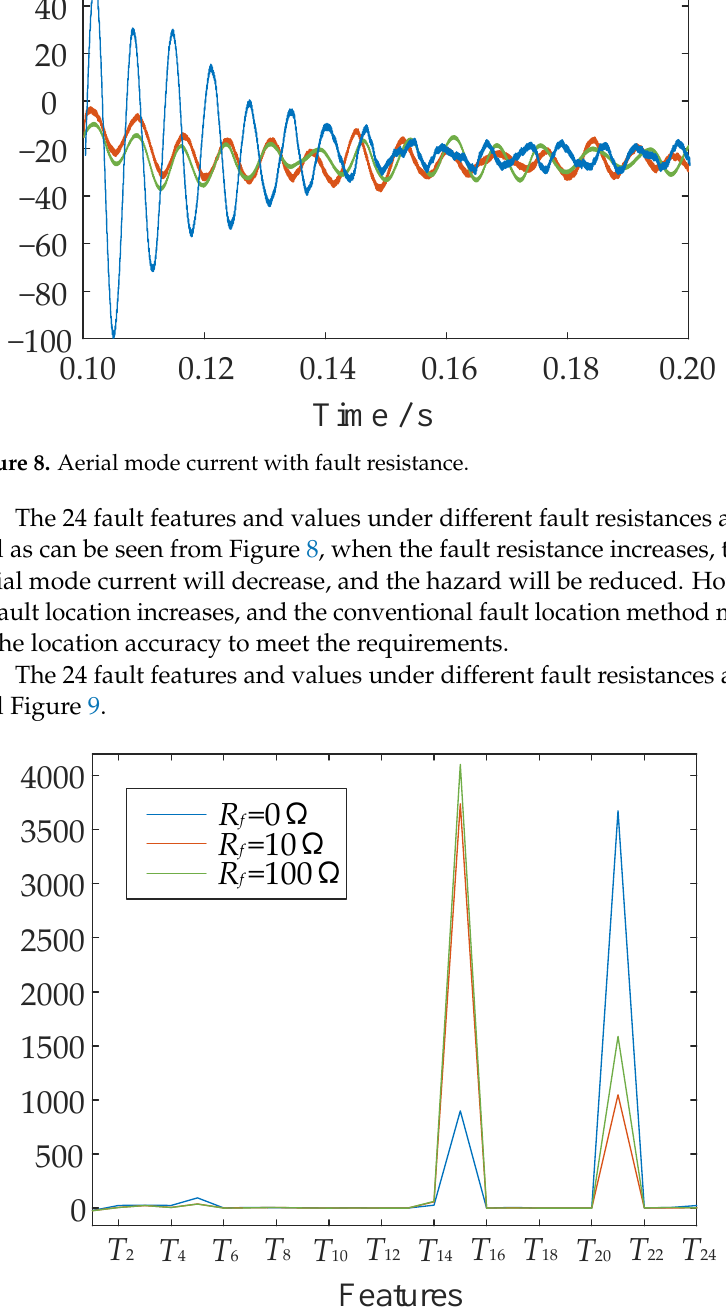
Figure 9. Fault features and values with fault resistance.